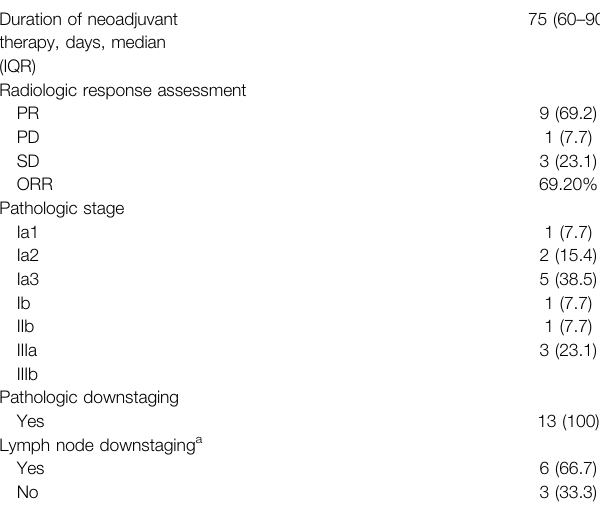
TABLE 3 | Surgery-related